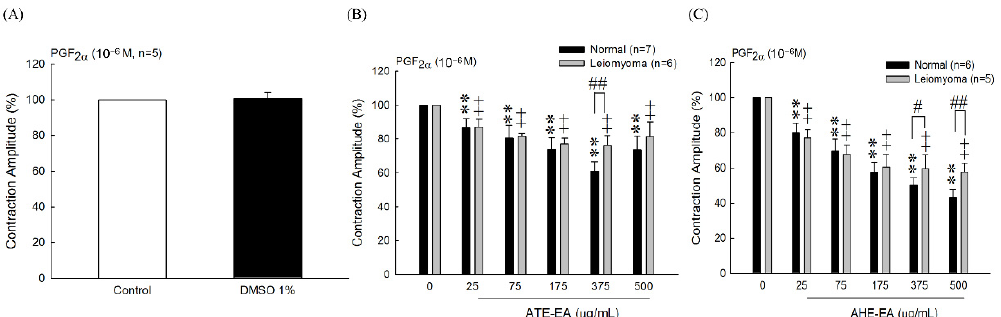
Figure 6. Effects of DMSO ( A ) and serial concentrations of ATE-EA ( B ) and AHE-EA ( C ) on PGF 2 α -induced contraction amplitude on both normal myometrial tissue and leiomyoma tissue, respectively. Data represent mean values ± SD. ** p < 0.01 compared with control. # p < 0.05, ## p < 0.01 compared with normal human uterine tissue. PGF 2 α , prostaglandin F2 alpha; ATE-EA, ethyl acetate fraction of adlay testa ethanolic extract; AHE -EA, ethyl acetate fraction of adlay hull ethanolic extract.